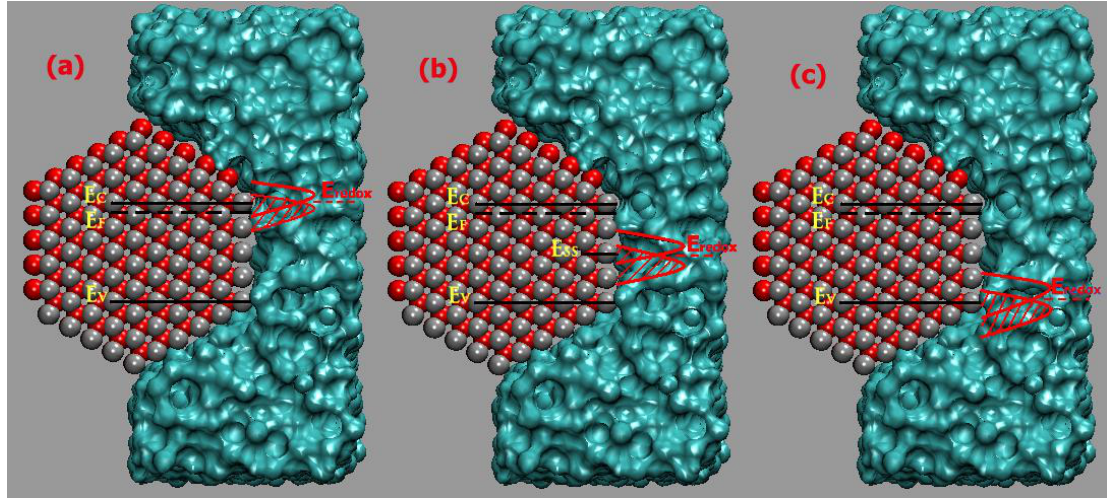
Figure 14. Three situations for a n-type semiconductor-electrolyte interface at equilibrium showing overlap of the redox energy levels with the semiconductor E states (b), and with the semiconductor E for the surface states as a first